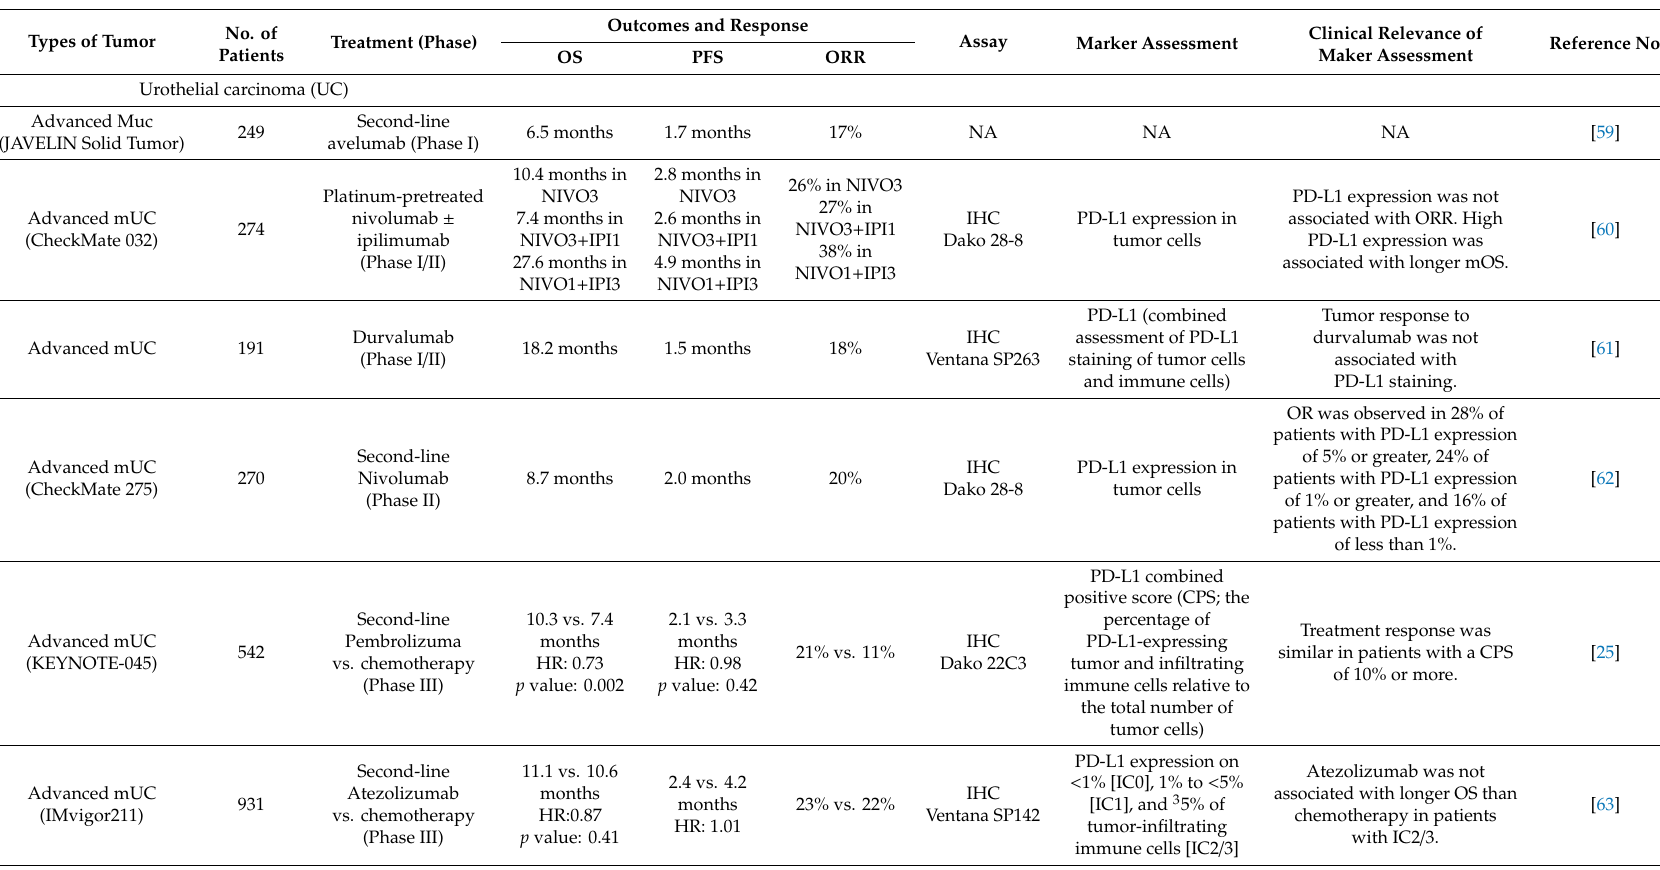
Table 2. Key trials of immune checkpoint inhibitors and association between treatment response and maker assessment in advanced urogenital malignancies. Types of